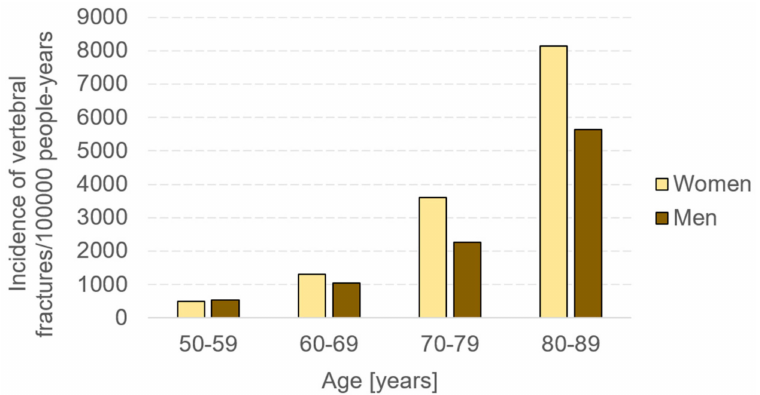
Figure 1. Incidence of vertebral fractures in Minnesota in years 2009–2010. The trend shows higher values for women >60 years old [5].